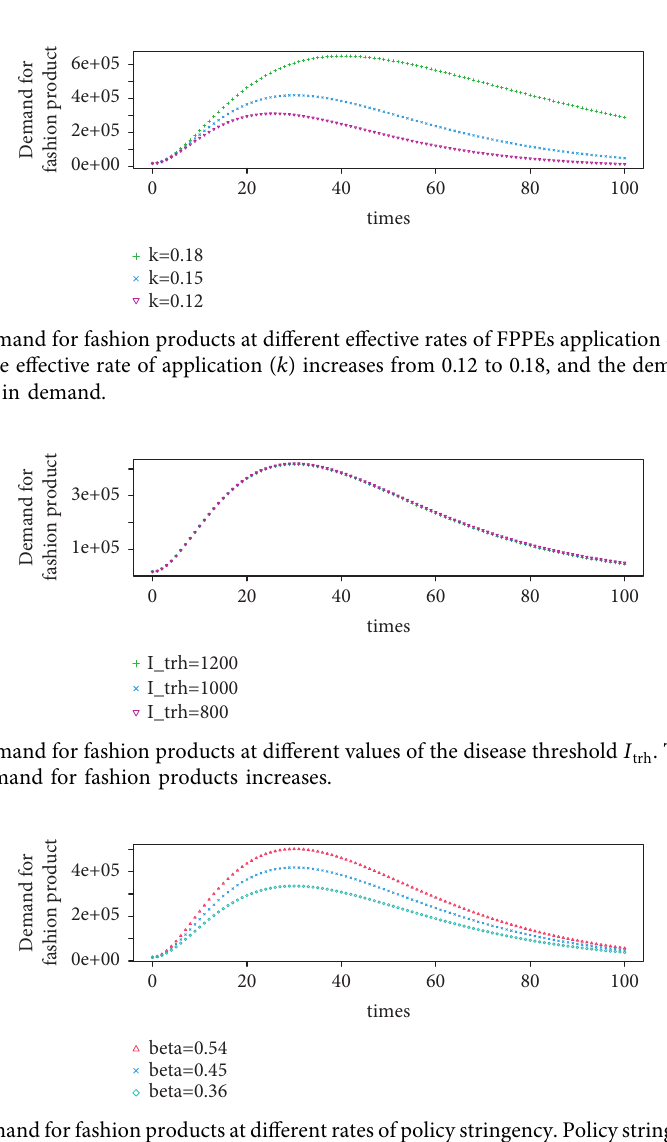
Figure 15: Simulation of the demand for fashion products at different rates of policy stringency. Policy stringency rate ( β ) declines from 0.45 to 0.36, and the demand shifts inward towards the horizontal axis, showing a fall. On the other hand, β increases from 0.45 to 0.54, which faces a corresponding increase in the demand for fashion products as indicated by the outward shift of the curve.